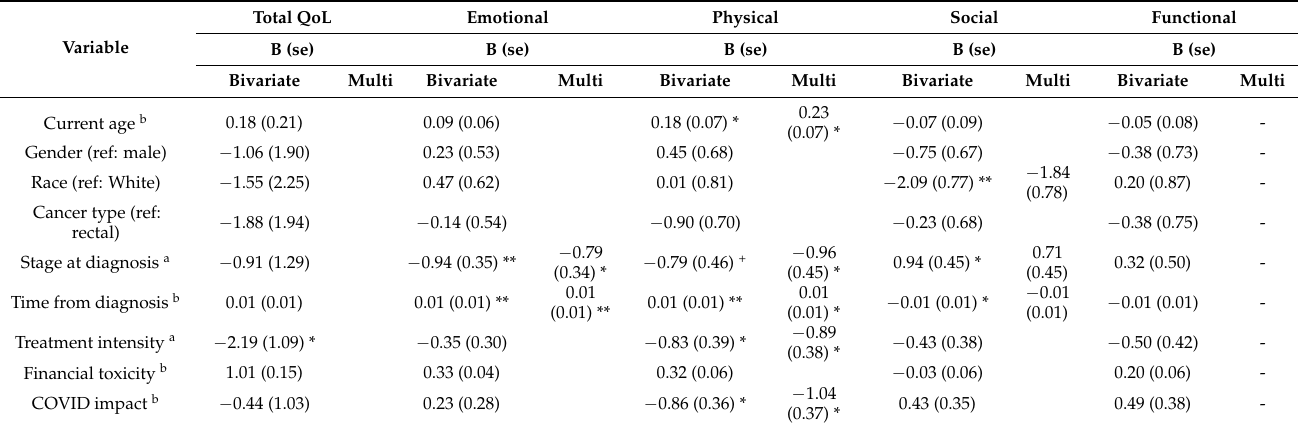
Table 3. Bivariate and multivariable linear regression for health-related quality of life domains among young adult colorectal cancer survivors ( n =